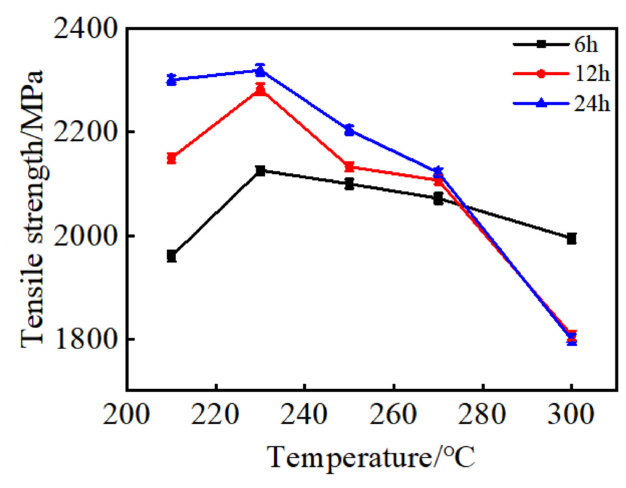
Figure 9. The curves of tensile strength versus isothermal temperature and